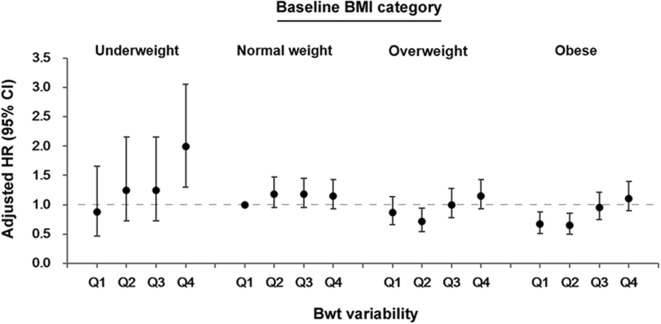
Association between body weight (Bwt) variability and the risk of dementia according to baseline body mass index (BMI) category. CI, confidence intervals; HR, hazard ratios.